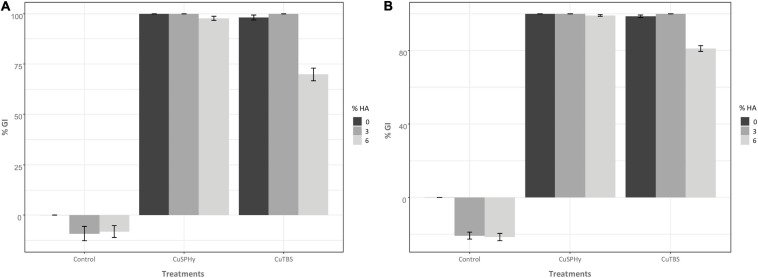
In vitro antifungal assay was performed comparing the mycelial growth inhibition of Pmi::gfp7
(A) and Pmi wild-type strain (B). In both graphics, the mycelial growth inhibition (% GI) is shown according to two different copper(II) compounds (CuSPHy and CuTBS) and to three percentages of HA (0, 3, and 6). Bar-plots show the % GI (average of three technical replicates per condition) measured four consecutive times (7, 14, 21, and 28 days post-inoculation) for each applied copper(II) concentration (0.05, 0.1, and 0.2% w/w). Bars show the standard error. A supplementary statistical analysis is reported in Supplementary Table 2.